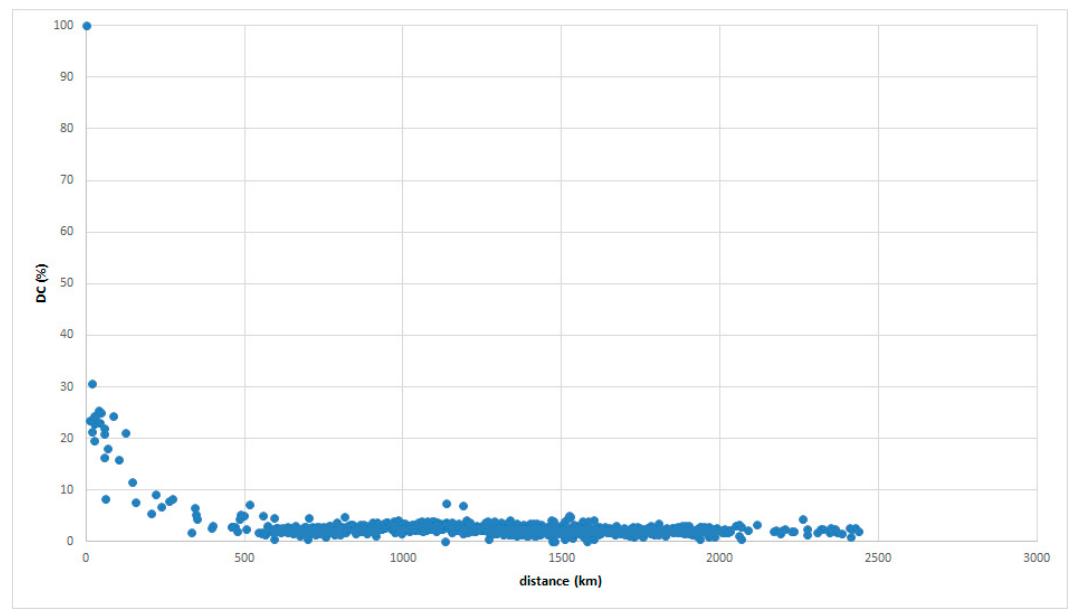
Figure 19. GAJ data for a reference place on Okinawa Island.